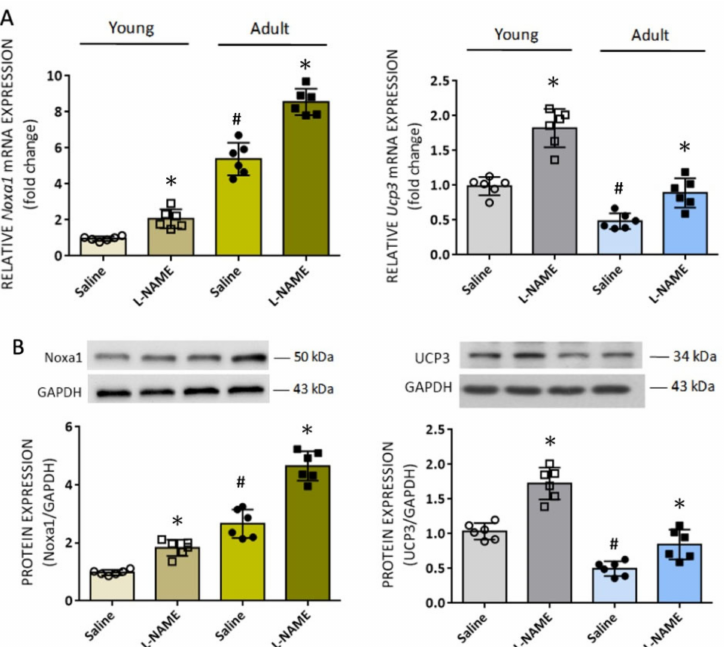
Figure 7. Age-dependent expression of ROS-related proteins in RVLM and the effect of systemic L - NAME treatment on their expressions: ( A ) Relative expression of Noxa1 and Ucp3 mRNA quantified by RT-qPCR in RVLM tissues from young (open circules or squares) and adult (filled circles or squares) rats on 14 days after i.p. infusion of saline or L -NAME. ( B ) Representative gels (insets) and densitometric analysis of results from Western blot changes in protein expression of Noxa1 and UCP3 in RVLM of young and adult 14 days after systemic L -NAME treatment. Data on protein expression were normalized to the respective saline control value, which is set to 1.0. Data are presented as mean ± SD, n = 6 per group. * p < 0.05 versus corresponding saline-treated groups, and # p < 0.05 versus saline-treated young rats in unpaired Student’s t